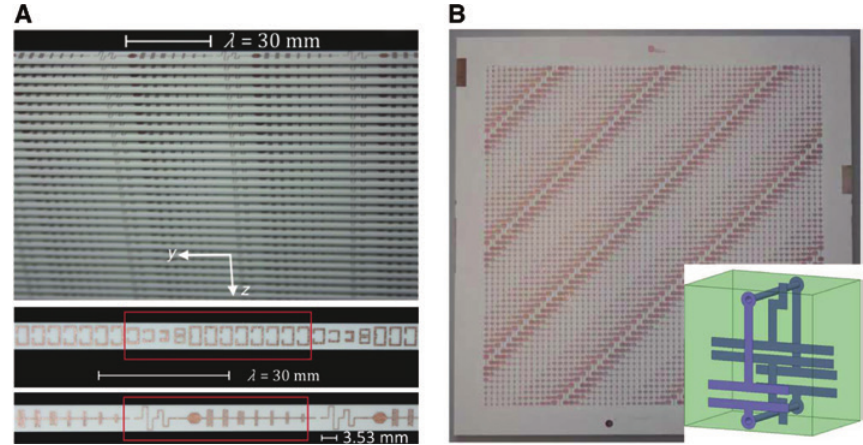
Figure 2: Samples of fabricated microwave refraction surfaces. (A) Photograph of fabricated 1D refraction metasurface for 45 ° refraction of a normally incident TM plane wave at 10 GHz using transverse- stacked wire/loop unit cells. Obtained from Ref. (21). (B) Photograph of fabricated 2D refraction surface at 10 GHz using planar wire/loop unit cell structures lying on a single plane. Obtained from Ref.